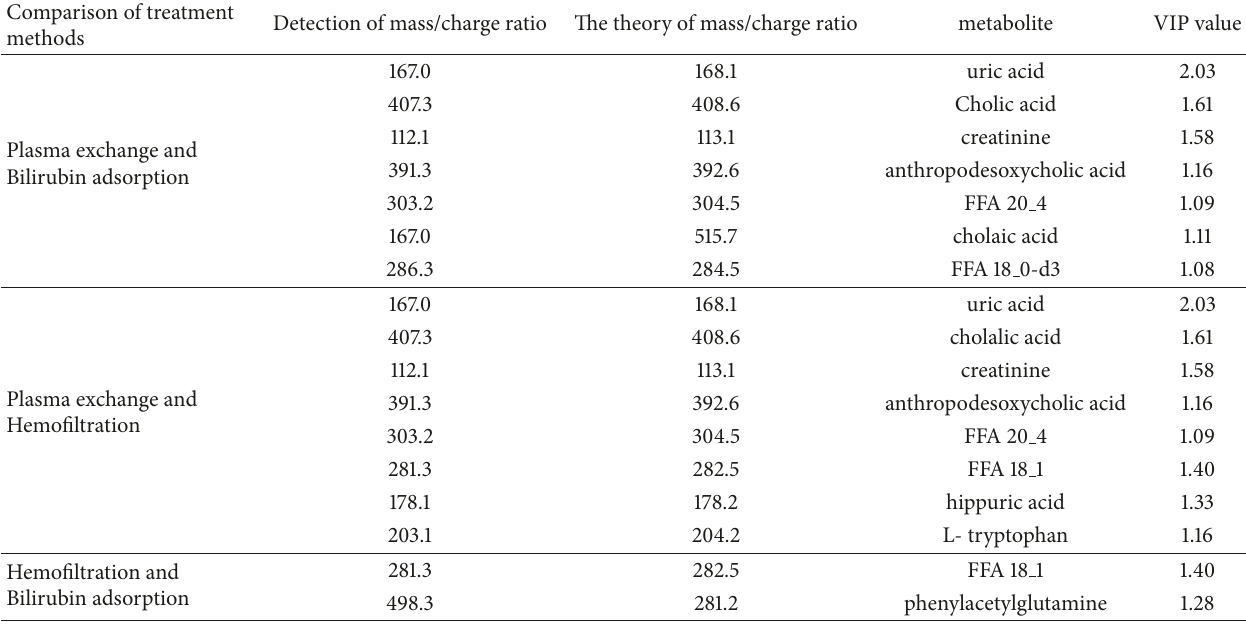
Table 11: Identification of characteristic metabolites about chronic liver failure with nonbioartificial liver.